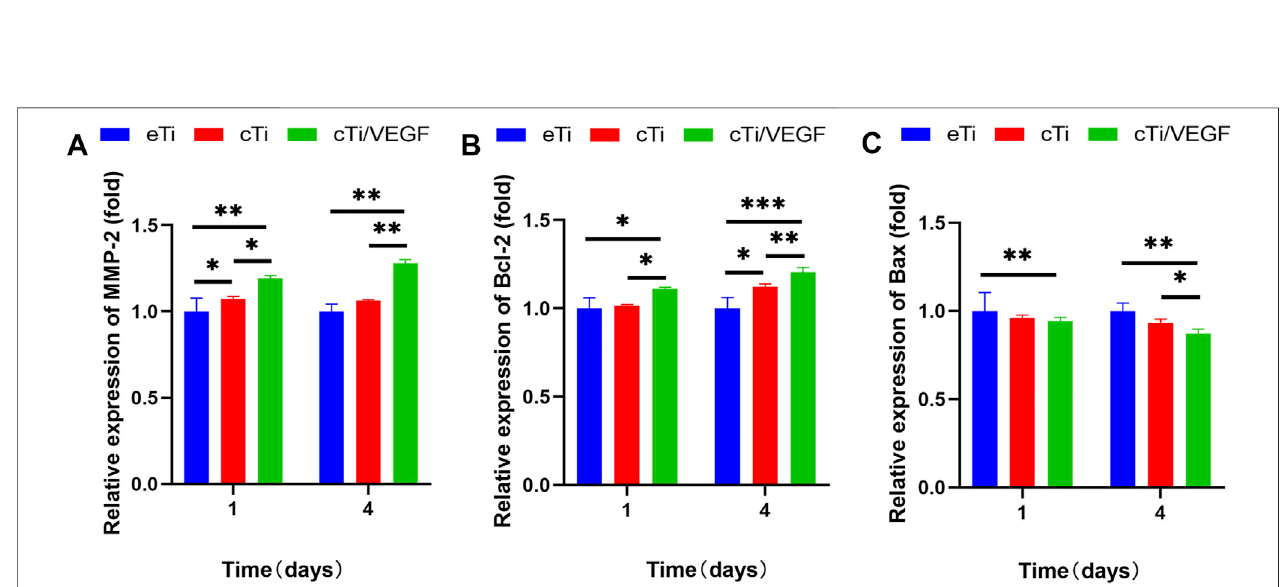
FIGURE4| RT-qPCRanalysisof (A) MMP-2 (B) Bcl-2,and (C) BaxgeneexpressioninHUVECsculturedwitheTi,cTi,andcTi/VEGFfor1and4 days,respectively (n (cid:1) 3).